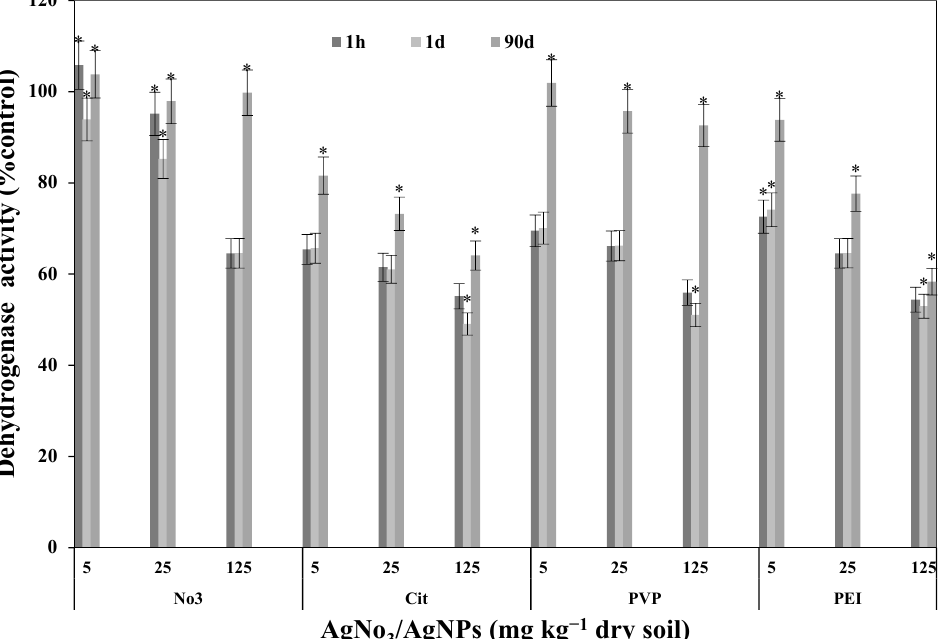
Figure 3. Activities of Dehydrogenase normalized by the mean of the control (no Ag/AgNPs added) replicates for samples treated with 5, 25, and125 mg AgNO 3 /AgNPs (Cit, PVP, PEI coated) kg − 1 dry soil after 1 h, 1 d, and 90 d. Values are the means of three replicates ± standard deviation. The asterisk (*) means significantly less than the control ( p < 0.05).